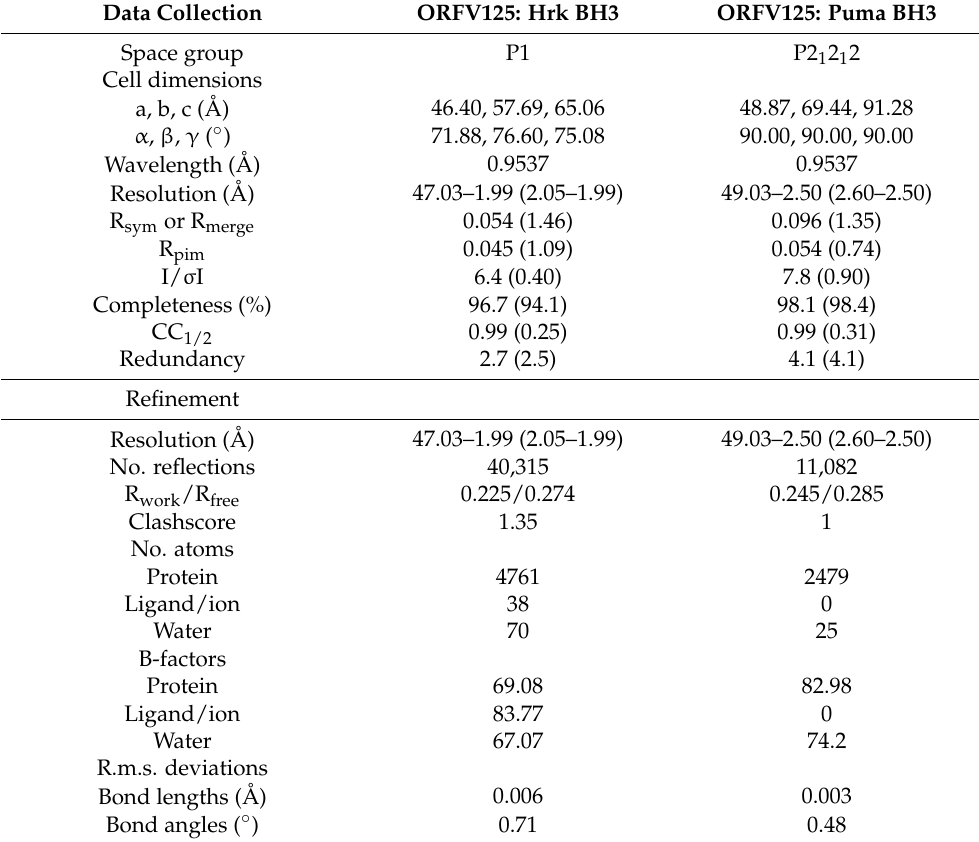
Table 1. X-ray crystallographic data collection and refinement statistics. Values in parentheses are for the highest resolution